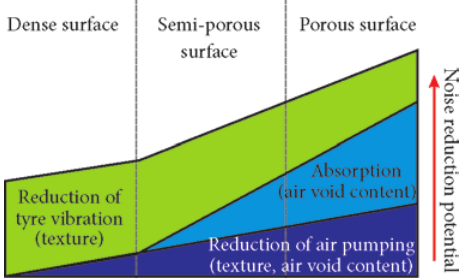
Fig. 6. Noise reduction potential and methods for different type of pavements (Beckenbauer